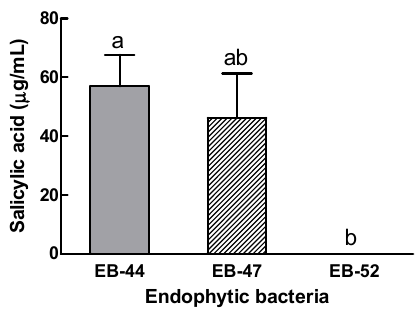
Figure 1. Salicylic acid concentrations in EB-44 ( Pseudomonas tremae ), EB-47 ( Curtobacterium herbarum ), and EB-52 ( C. plantarum ) isolated from the leaves of Salix babylonica . Data represent means ± standard deviations of four independent replications for each treatment. Means with different letters are significantly different at p < 0.05 by Duncan’s multiple range test.